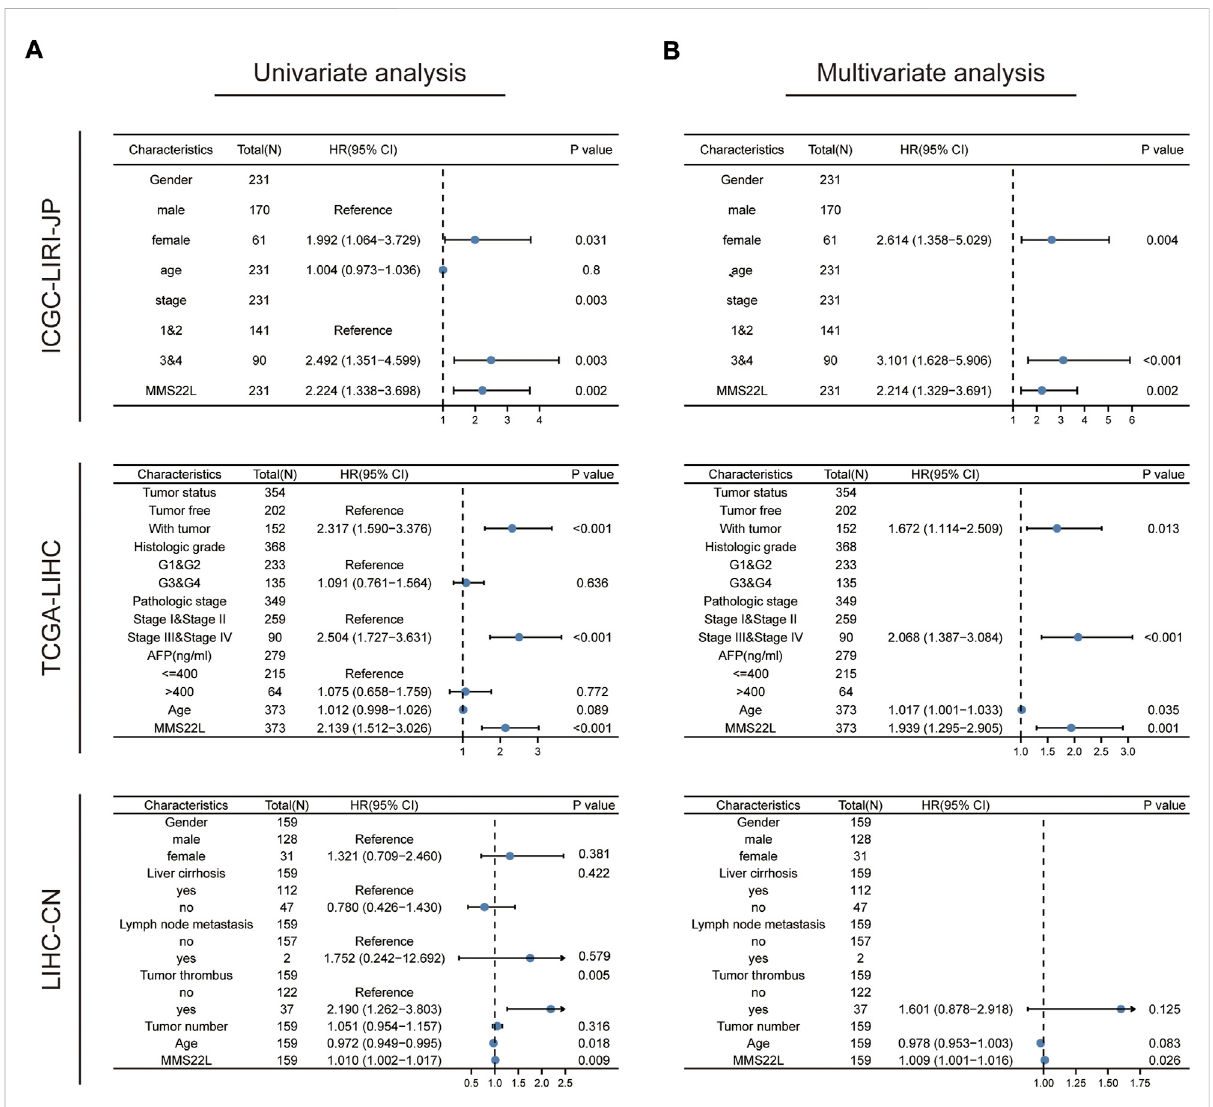
FIGURE 8 Validation of the independency of methyl methanesulfonate-sensitivity protein 22-like (MMS22L) for prediction of overall survival in patients with HCC. (A,B) Univariate and multivariate cox regression analysis validated that MMS22L was an independent predictor for OS in TCGA-LIHC, ICGC-LIRI-JP, and LIHC-CN